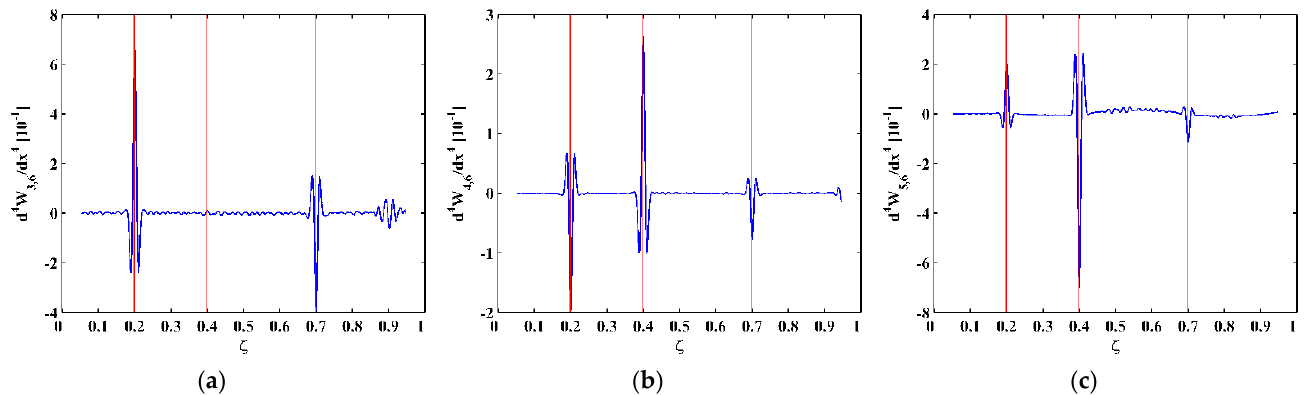
Figure 6. Derivatives of the ( a ) third, ( b ) fourth, and ( c ) fifth multi-scale mode shapes (locations of cracks are indicated by red lines).